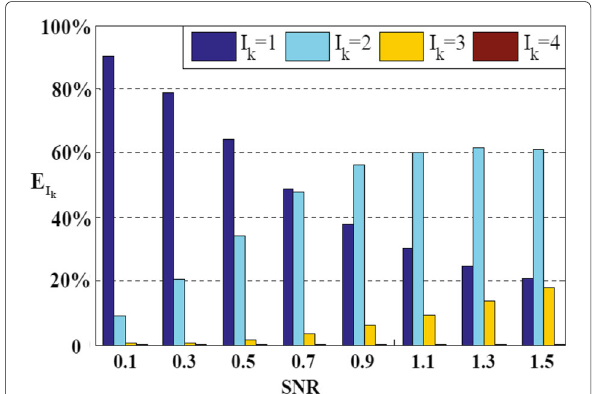
Fig. 5 Statistical distribution of E I SNR (cid:2) (cid:3) s j , j 2 ∈ 2 , k seven compressed metrics should be stored in the SMC for each time slot (1 × 2 + 7 × 5 = 37 bits).